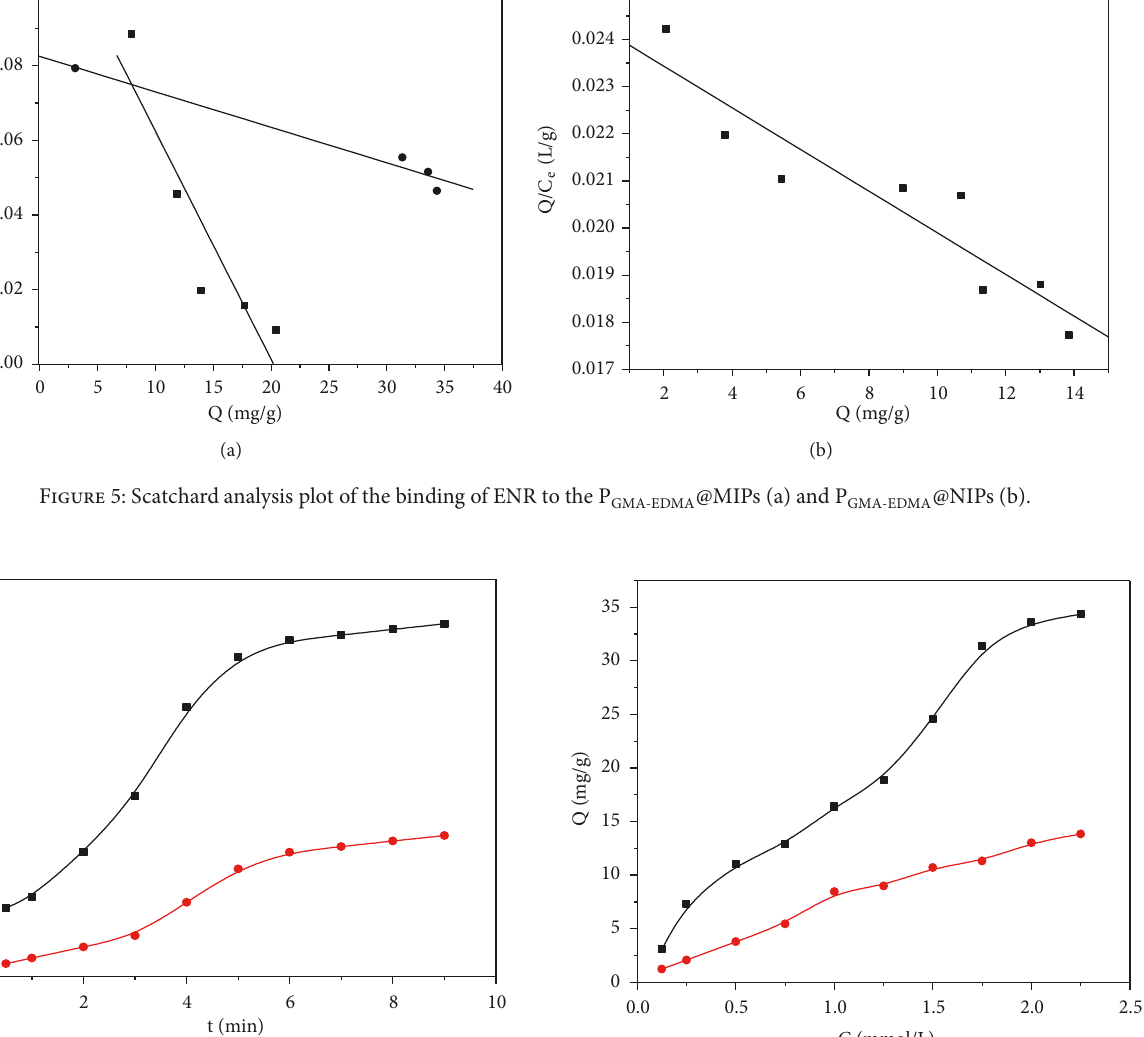
Figure 7: Adsorption isotherm of P GMA P GMA @NIPs. - EDMA